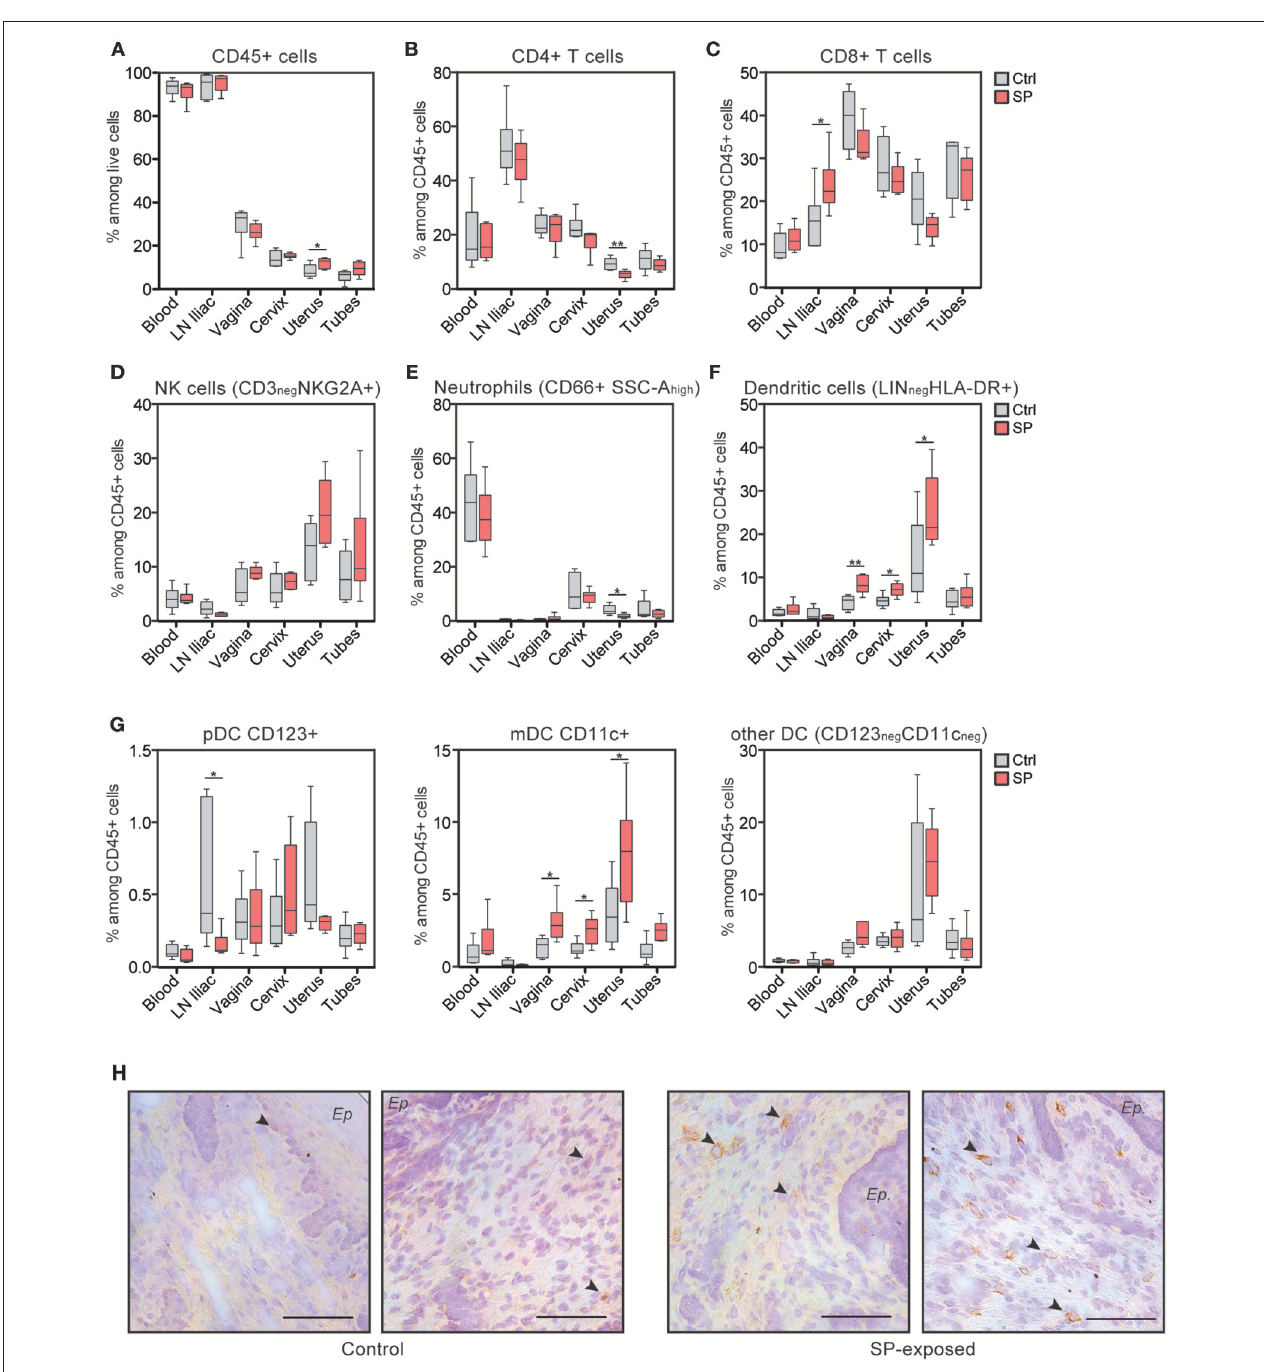
FIGURE 3 | CD11c + mDC are recruited to the FRT of SP exposed animals. (A) Distribution of leukocytes among living cells. Percentage of CD4 + T cells (B) , CD8 + T cells (C) , NK cells (D) , neutrophils (E) , and total dendritic cells (F) among leukocytes in the various compartments. (G) Percentage of dendritic cell subtypes [i.e., plasmacytoid DC (pDC), mDC, and other DC]. Control animals (Ctrl) are indicated in gray and SP exposed animals (SP) in red. The Mann-Whitney test (*) was used to compare animal groups (* p < 0.05). (H) Localization of mDC with anti-CD11c antibody in vaginal tissue sections from control (left panel) and SP-exposed animals (right panel). Black arrows indicate brown CD11c + cells and the black bar indicates 100 µ m. Ep, epithelium. significant canonical pathways and upstream regulators ( p < respectively. We separately analyzed downregulated and up- 0.003) are detailed under each heatmap. In the iliac LNs, SP regulated gene sets resulting from SP exposures using Ingenuity exposures downregulated genes associated with stress Pathway Analysis (IPA). Functional enrichment of the most